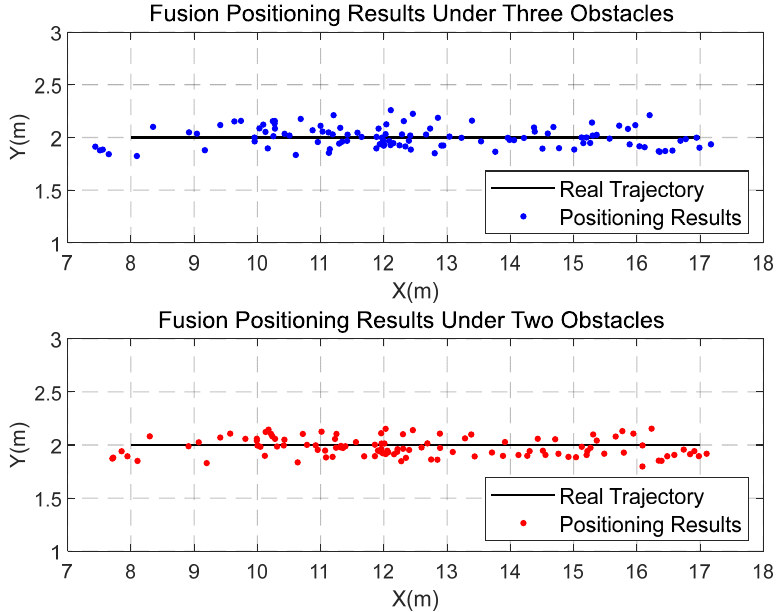
Figure 15. Fusion positioning results with different number of obstacles.